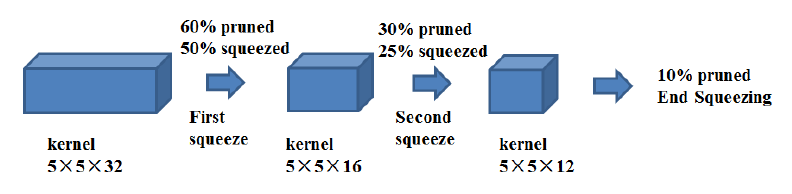
Figure 3. Iterative squeezing of convolutional